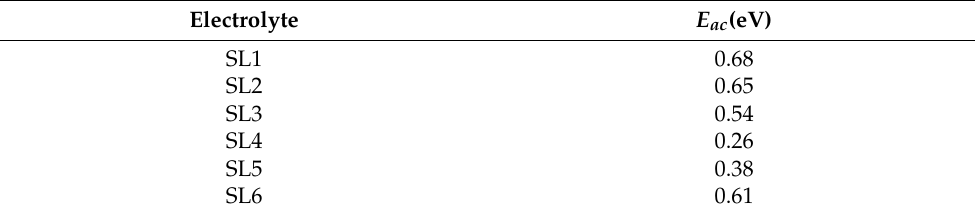
Table 4. The value of E ac for the salted